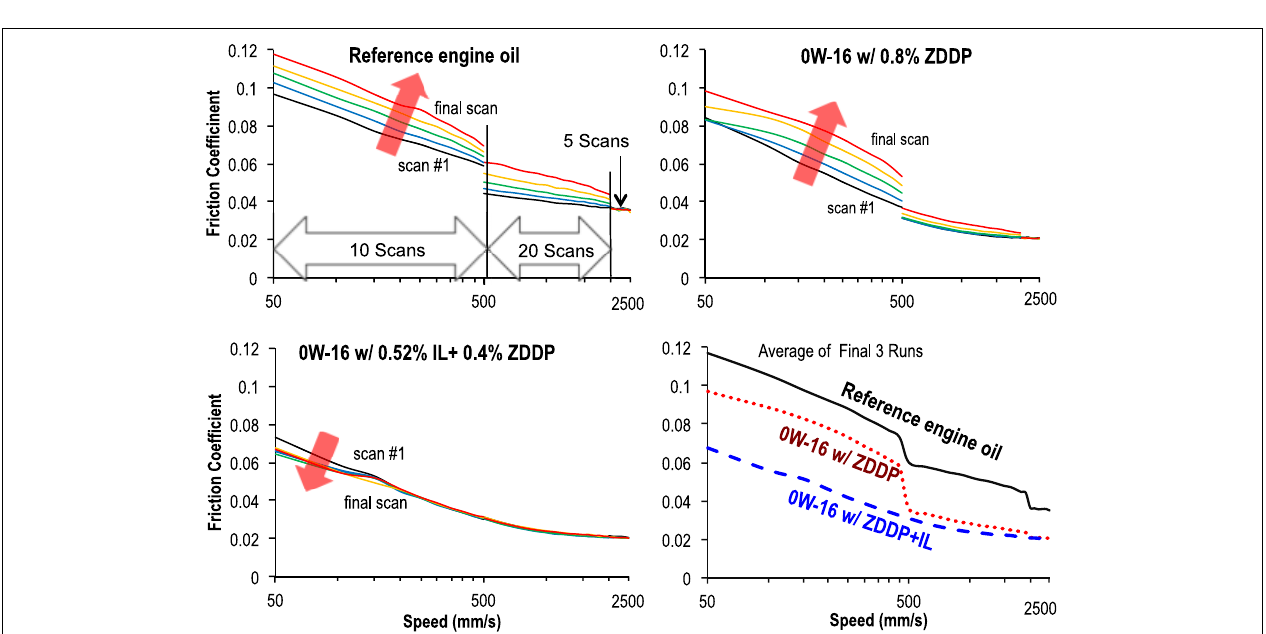
FIGURE 6 | Stribeck curves (MTM method 2) . Only five scans in each speed range are shown for clarity. The summary represents the average of the final three scans for each lubricant.